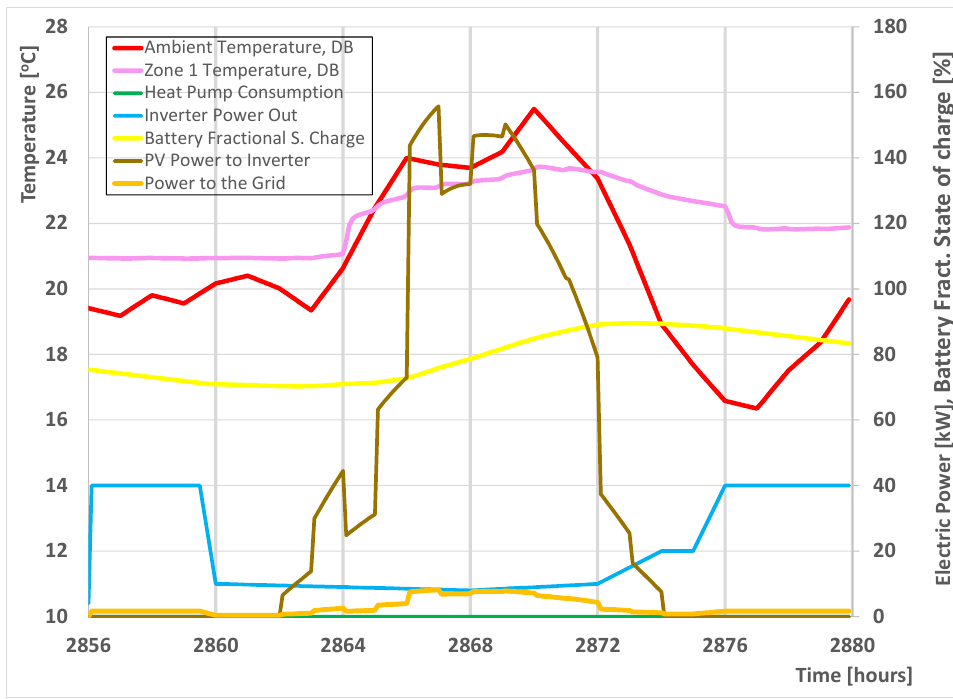
Figure 12. Ambient temperature, room temperature, heat pump electricity consumption, and PV inverter out power variation, during a sunny weekday of the end of April, starting at midnight.